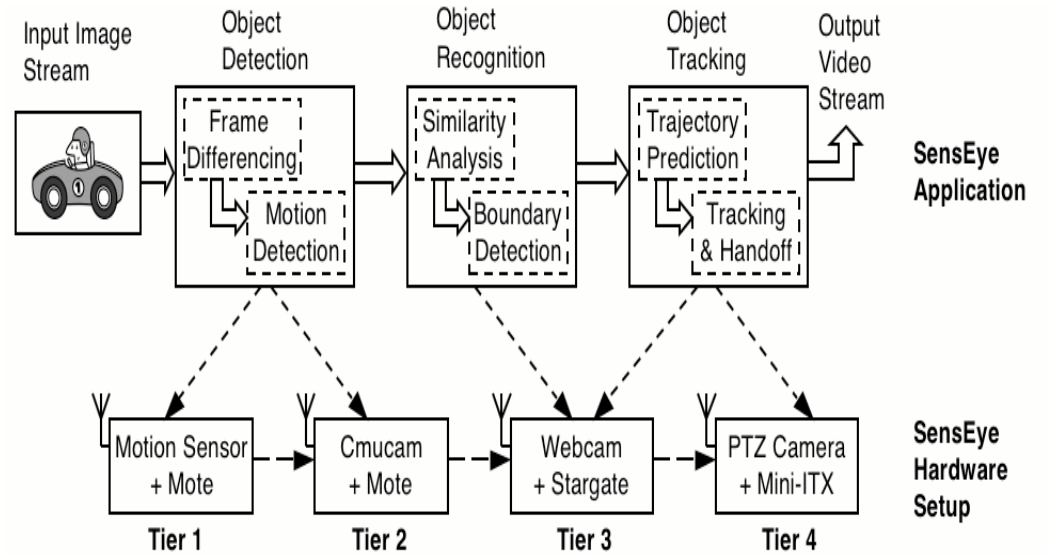
Figure 3. Software architecture of